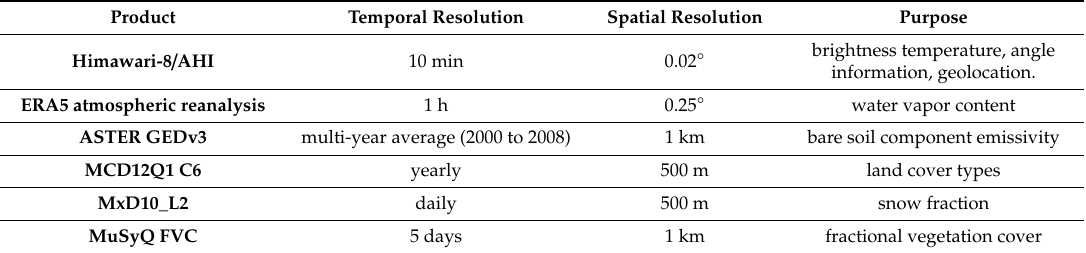
Table 3. Summary of the inputs used in LST retrieval by the operational split-window (SW)